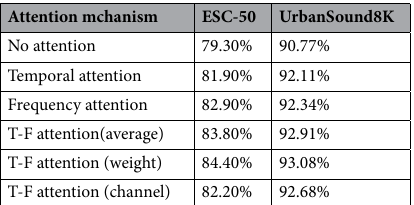
Table 3. Classification accuracy after using different attention mechanisms.